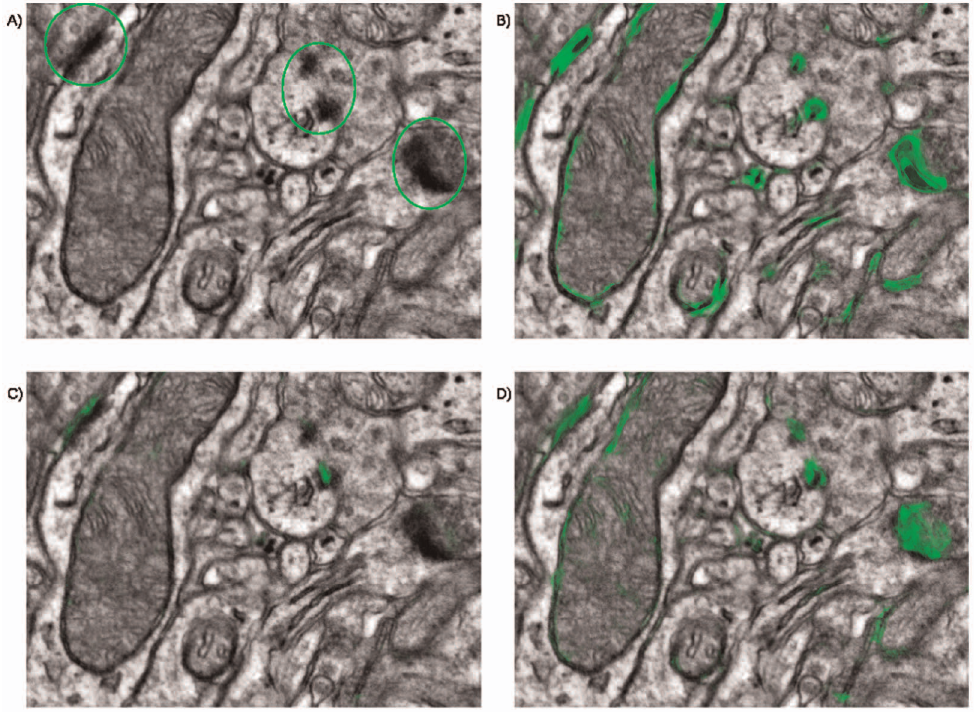
Figure 6. Benefits of 3D processing with upsampling. A: raw data, with three synapses in green circles. B: probability map of the synapse class after classification with 2D features – low precision of the prediction. C: same for classification with 3D features without upsampling – low recall. D: same for classification with 3D features and upsampling by 2 along the z axis. The remaining false positives are filtered out by the object classification step.